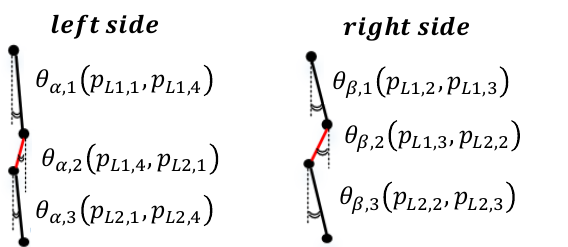
Figure 7. Descriptions of each angle in the PSD methodology. There are four extreme points of each lumbar vertebra, p Li ,1 , p Li ,2 , p Li ,3 , and p Li ,4 , which correspond to the upper-left, upper-right, lower-right, and lower-left points, respectively, of a lumbar vertebra i . Each vertebral region can be calculated from the left- and right-sided angles between the proximal line segments. θ α and θ β represent the left and right side, respectively.